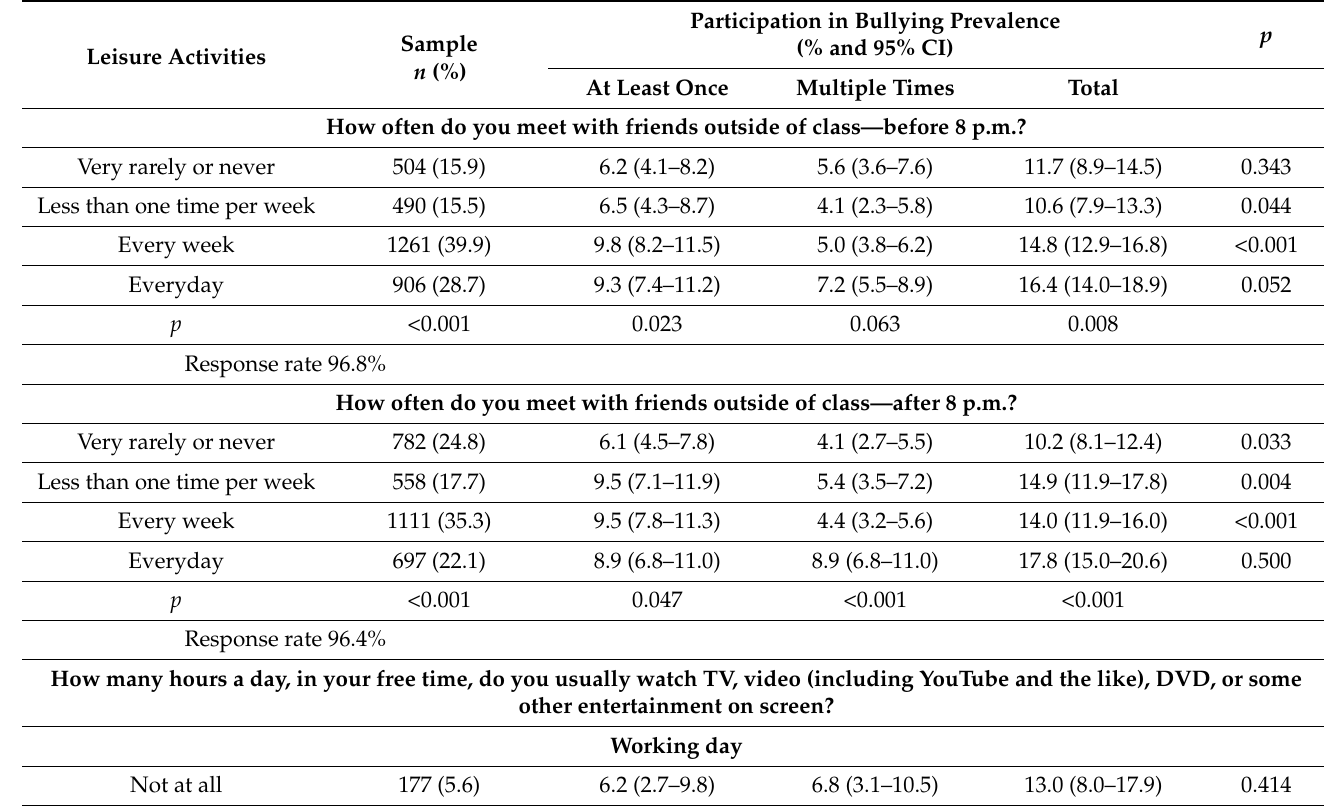
Table 3. Prevalence of bullying among school-age children and leisure activities, Serbia,